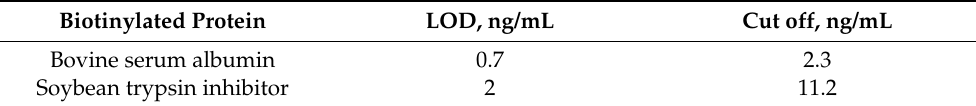
Table 1. LODs for aggregation ICA using two protein carriers . Biotinylated Protein